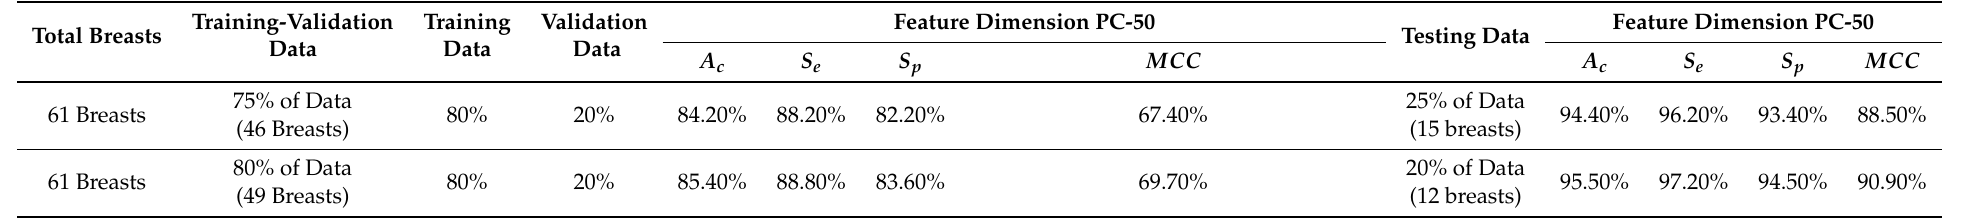
Table 10. Training, validation, and testing dataset: classification results applying PCs extracted from real parts of MammoWave’s complex S 21 signals with SVM G